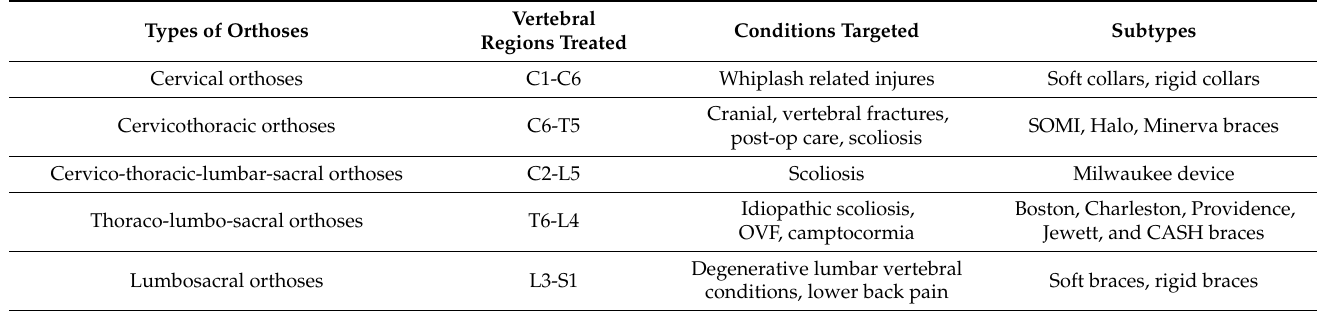
Table 5. The various types of orthoses, regions of the vertebrae treated, pathologies targeted, and subtypes of each